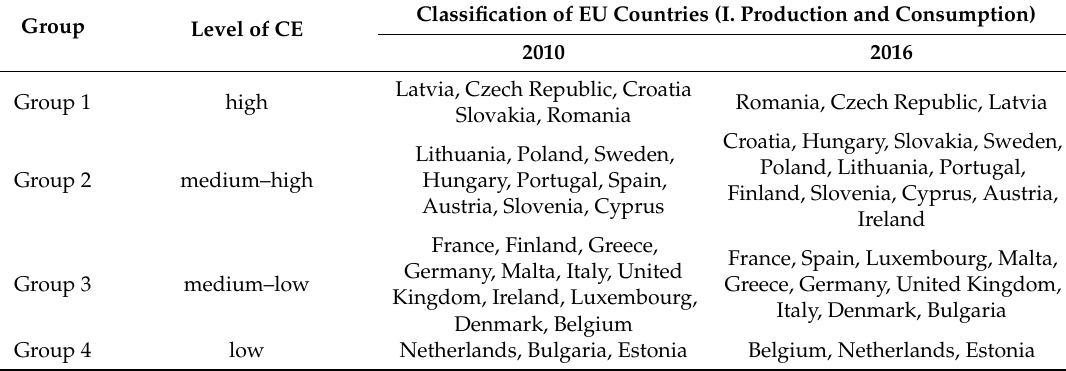
) in 2010 and in 2016. i Classification of EU Countries (I. Production and Consumption) 2010 2016